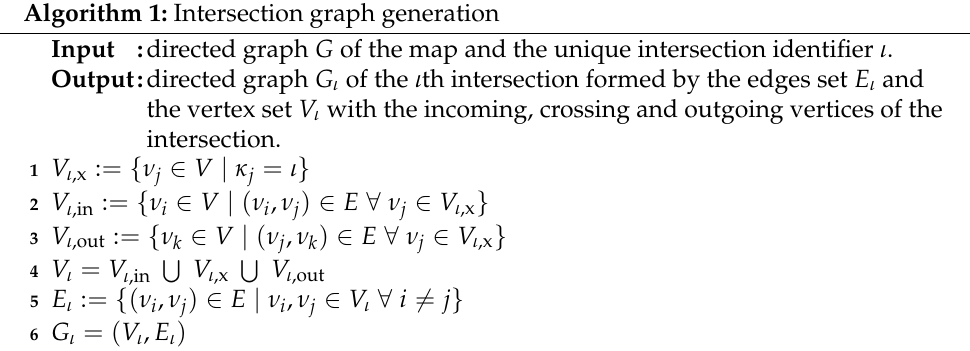
Algorithm 1: Intersection graph generation